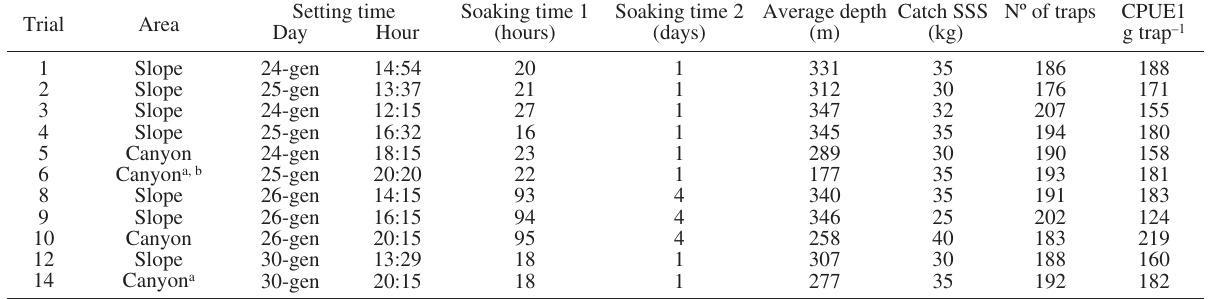
Table 1. – General information for individual fishing trials (each corresponding to the deployment of a trap line): number of traps in each line, location, depth, starting date, starting time, duration (in hours and days), total catch of Plesionika edwardsii and catch per unit effort (CPUE) in g trap –1